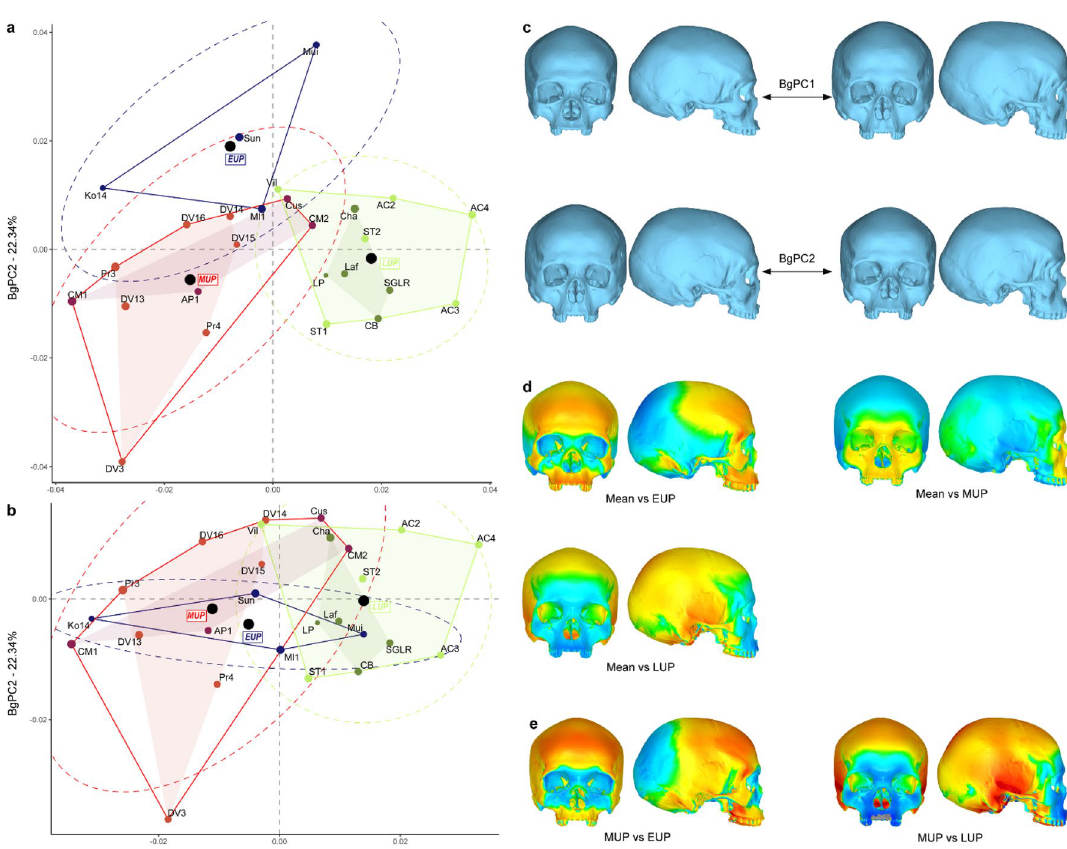
Figure 3. Between-group PCA discriminating the EUP, MUP and LUP groups. ( a ) morphospace of the bgPCA; ( b ) morphospace after cross-validation; ( c ) shape changes for bgPC1 and bgPC2; ( d ) surface deviation spectrum showing the shape difference between the mean shape of the entire sample versus the mean shape of each group; ( e ) surface deviation spectrum showing the shape difference between MUP and the two other fossil groups. For each group, black circles indicate the position of the centre, and the dotted ellipses represent the 90% confidence intervals. The size of the data points reflects the centroid size of the specimens.